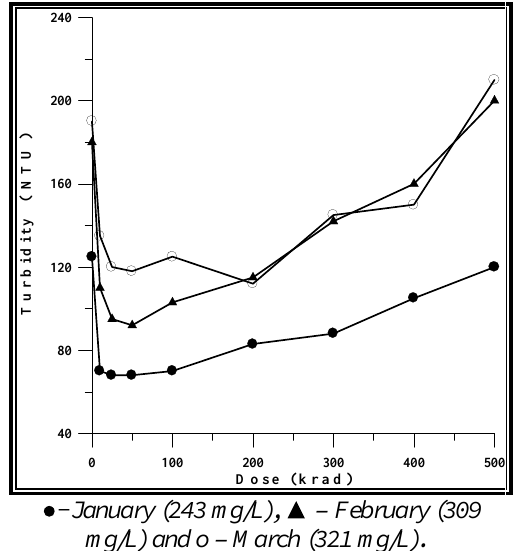
Figure 2: Turbidity values of irradiated sample of wastewater for BOD 5